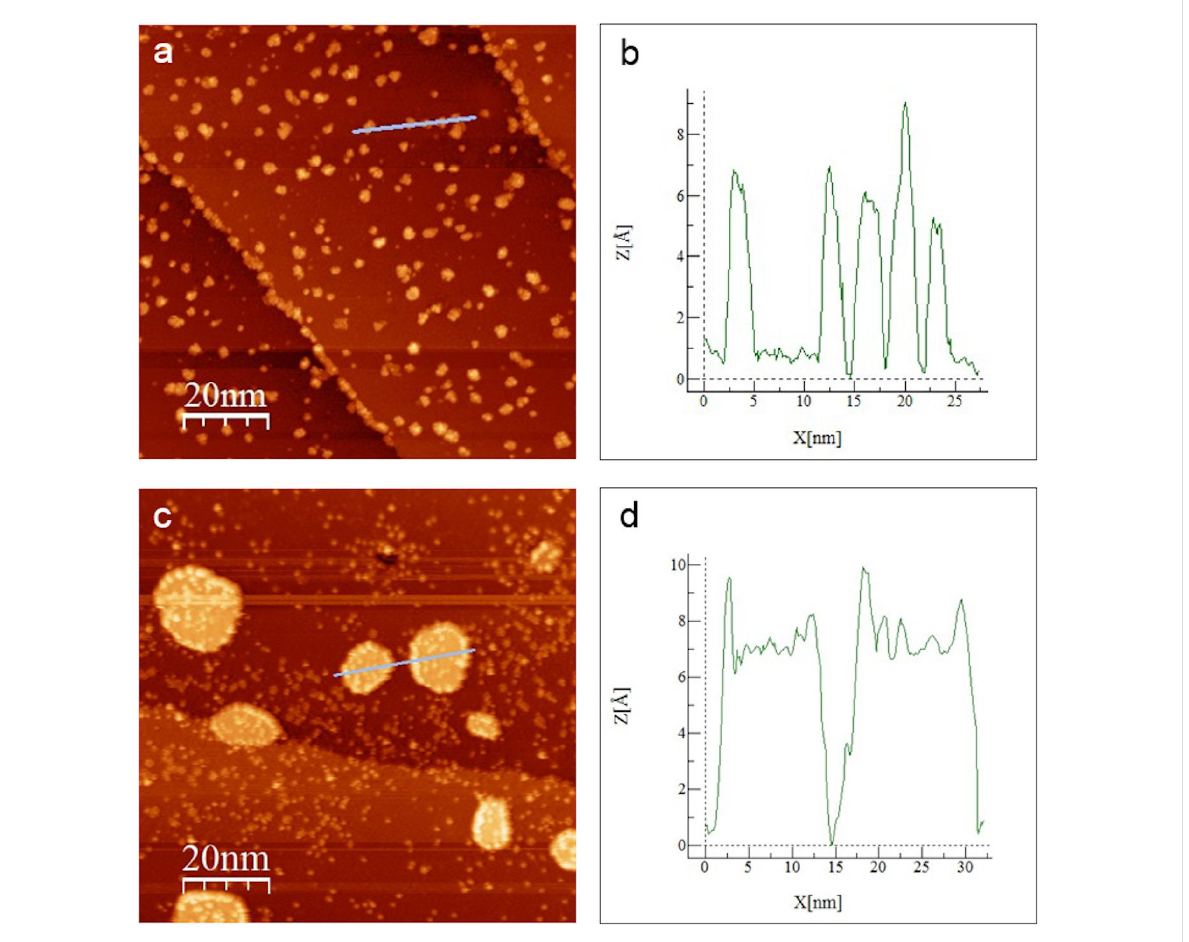
Figure 5: STM images of the initially W 3 O 9 -covered w’-TiO x phase grown on Pt 3 Ti(111) after annealing the sample for 5 min. (a) Flashing the surface to 600 K leads to cluster agglomerations on the terraces and decoration of the step edges (98 × 98 nm; U B = 1.48 V; I T = 75 pA). (b) The height profile along the line marked in (a). The cluster agglomerations have a typical thickness between 0.6 and 0.9 nm. (c) Flashing the surface to 900 K leads to the formation of larger WO 3 islands (98 × 98 nm; U B = 1.60 V; I T = 75 pA). (d) The height profile along the line marked in (c). The islands have always a thickness of ≈ 0.6 nm with residues of clusters on